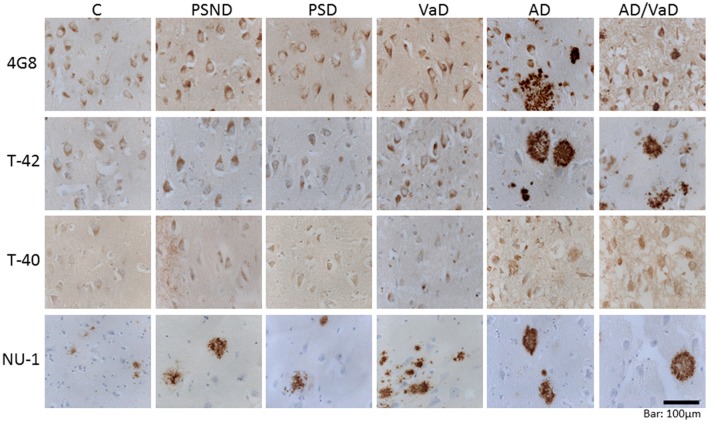
Illustrative images of amyloid pathology in the CA1 sub-region across different markers and across disease groups and aging controls. There is higher expression of amyloid in the AD and AD_VaD groups compared with the VaD, PSD, and PSND and control groups. The level of amyloid immunoreactivity is similar between 4G8 and T-42 but much lower in T-40 and NU-1.